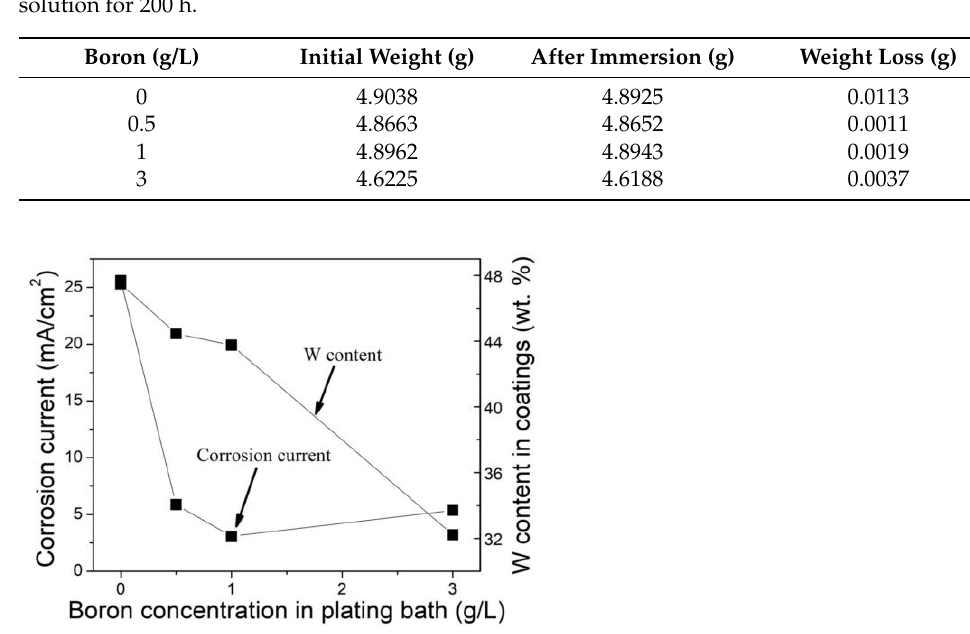
Figure 7. Corrosion current and tungsten contents of Ni-W and Ni-W/B coatings with varying boron concentrations.